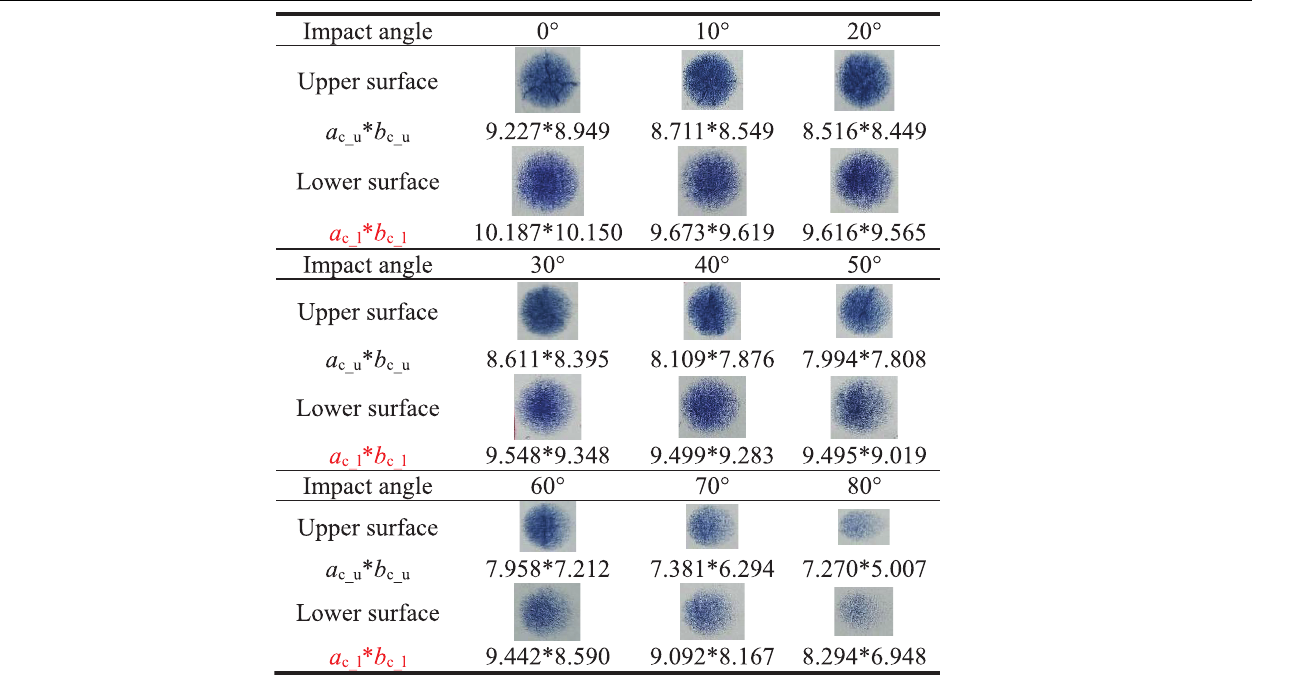
Table 1. Upper and lower contact surfaces at different impact